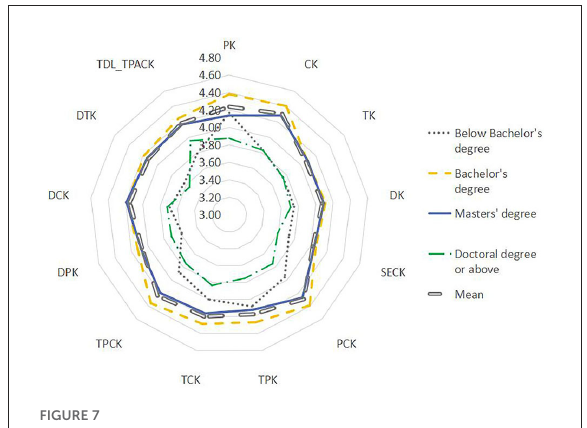
FIGURE7 Academic qualifications difference.